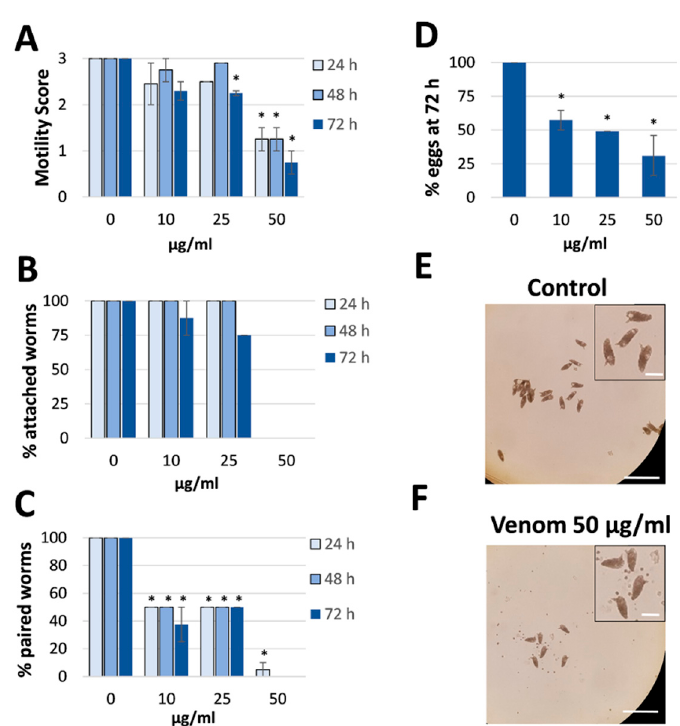
Figure 3. E ff ect of Rhynocoris iracundus venom on Schistosoma mansoni motility, pairing and egg production. Worm pairs were treated with di ff erent concentrations of venom (10–50 µ g / mL) for a period of 72 h. We measured ( A ) motility, ( B ) the percentage of worms attached to the base of the plate, and ( C ) pairing stability every 24 h. ( D ) The number of eggs produced within 72 h relative to the untreated control. The shape of the eggs appeared normal after venom treatment (inserts). Graphs show a summary of two experiments with 5–8 worm pairs (mean ± SEM). Significant di ff erences vs. the control are indicated (* p < 0.05, Wilcoxon rank sum test). ( E , F ) Representative images showing the number of eggs produced by untreated control worms and venom-treated worms (50 µ g / mL). Scale bars = 250 µ m, for inserts = 60 µ m.